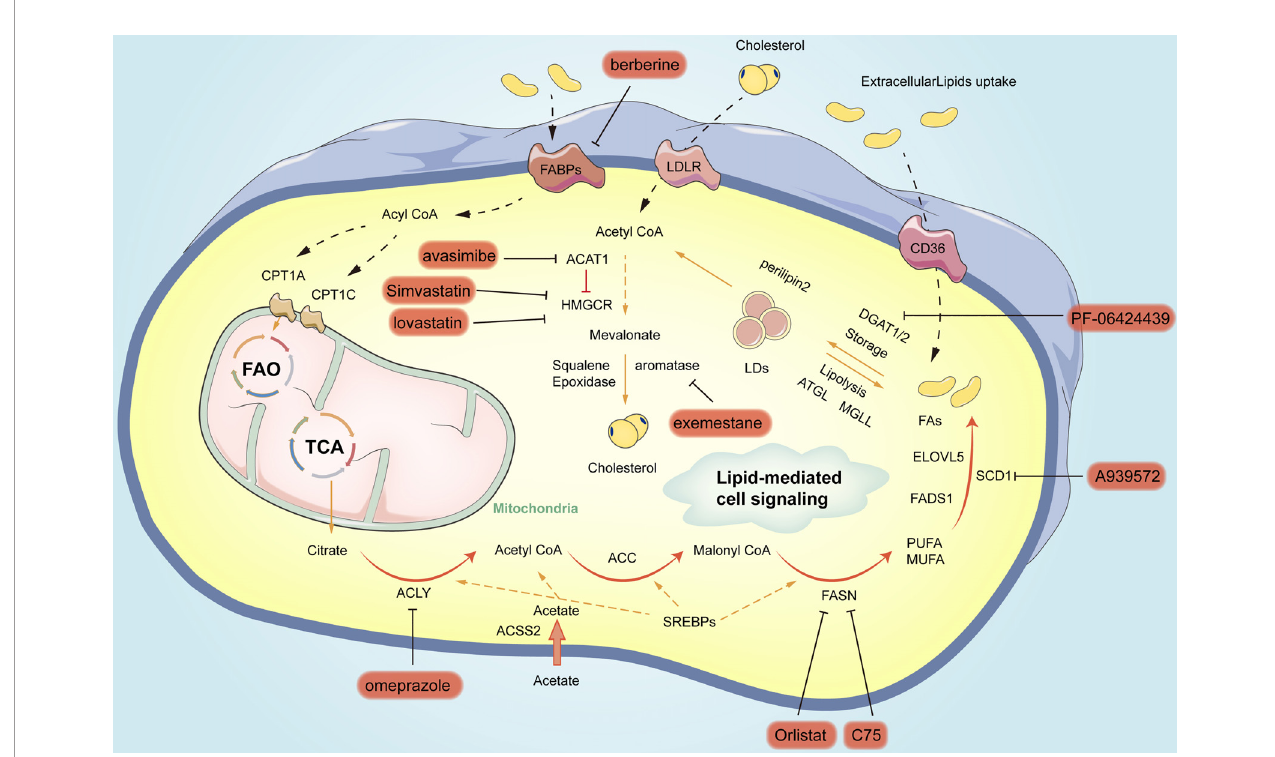
FIGURE 3 | Summary of small-molecule inhibitors of lipogenic enzymes in gastric cancer. In orange circles are the names of inhibitors for different vital enzymes for blocking the related